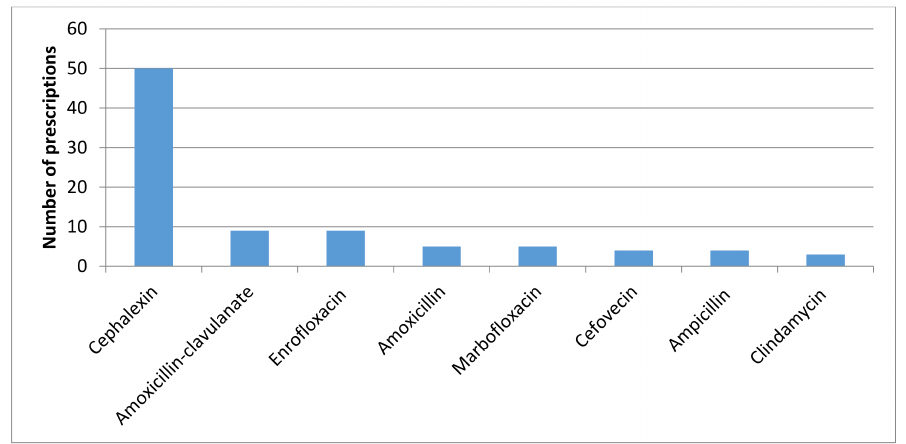
Figure 1. Histogram of the frequency of systemic antimicrobials agents initially prescribed by 100 Colombian veterinarians to treat canine superficial